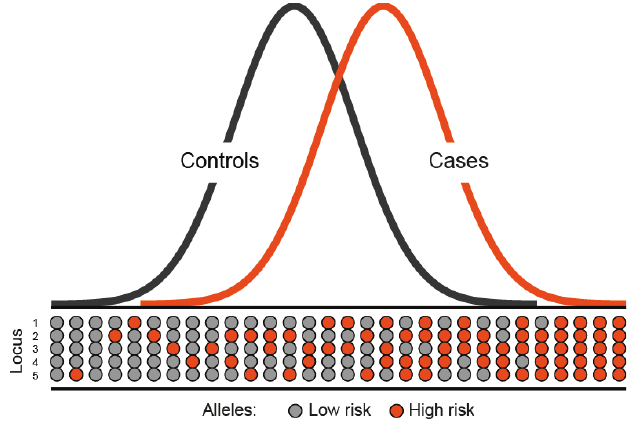
Figure 1. Polygenic model of disease susceptibility. The distribution of risk alleles in both cases and controls follows a normal distribution. However, cases have a shift towards a higher number of high risk